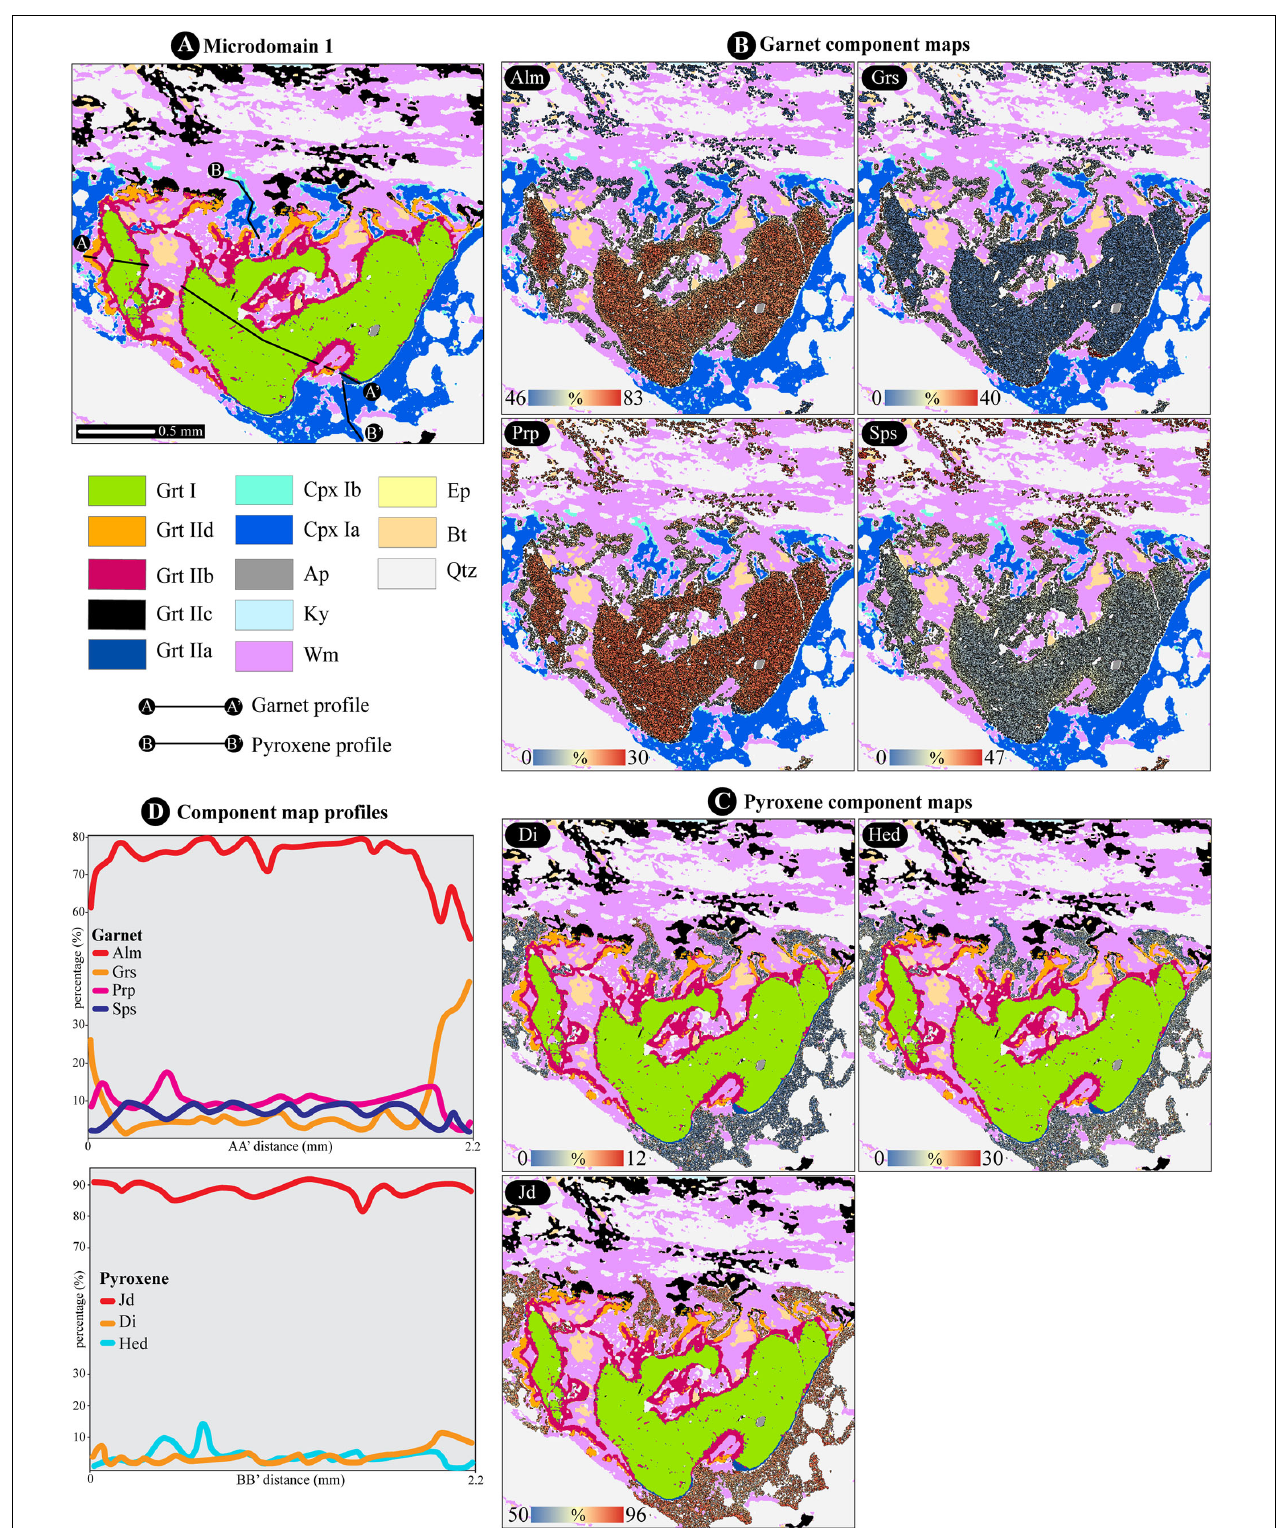
FIGURE 9 | (A) Results of third cycle of Q-XRMA for pre-alpine Grt microdomain and localization of chemical profiles. (B) Component maps for Grt (i.e., Alm, almandine; Grs, grossular; Prp, pyrope; Sps, spessartine). (C) Component maps for Cpx (i.e., Di, diopside; Hed, hedenbergite; Jd, jadeite). (D) Component profiles for Grt and